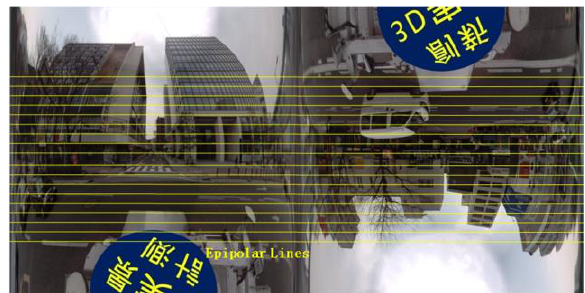
Figure 6. Panoramic epipolar image and its horizontal parallel straight epipolar lines.